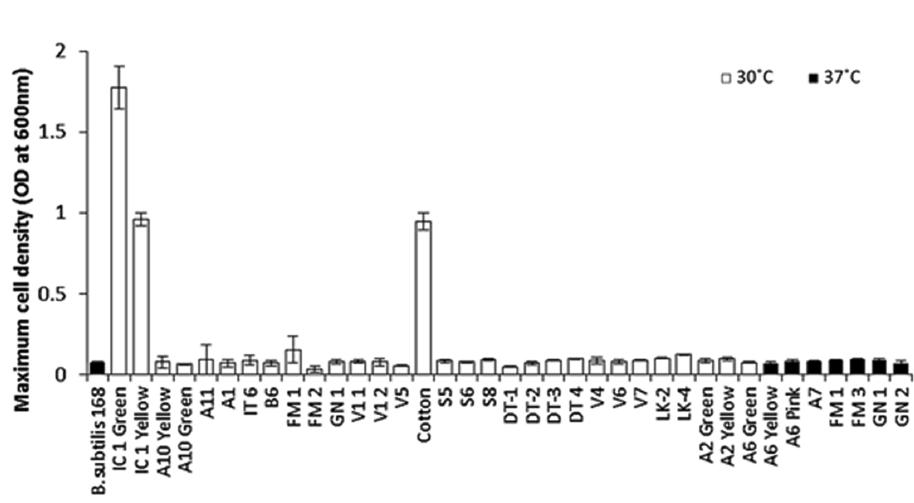
Fig. 1. Relative abilities of primarily screened bacterial isolates to grow on defined minimal medium containing L-tartrate as sole carbon source Maximum cell densities were measured after 48 h of incubation under aerobic condition at respective temperature of isolation. Results are depicted as Mean ± SD of 3-4 independent Table 1. Partial 16S rDNA sequencing-based molecular identification of tartrate utilizing bacterial isolates No.